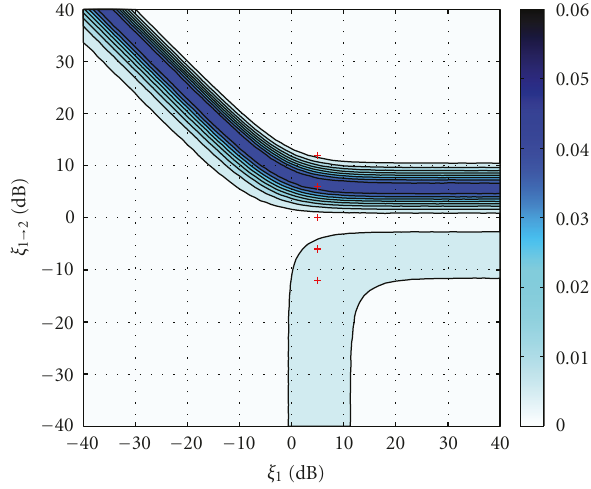
Figure 8: Contour plot of the variance of the LR estimates. The variance has been determined empirically ( K 1 = 32, K 2 = 32, R = 32). ξ 1 denotes the SNR in block 1, ξ 1 → 2 the change in SNR at the transition from block 1 to 2. The crosses illustrate the points for which the LR histograms are plotted in Figure